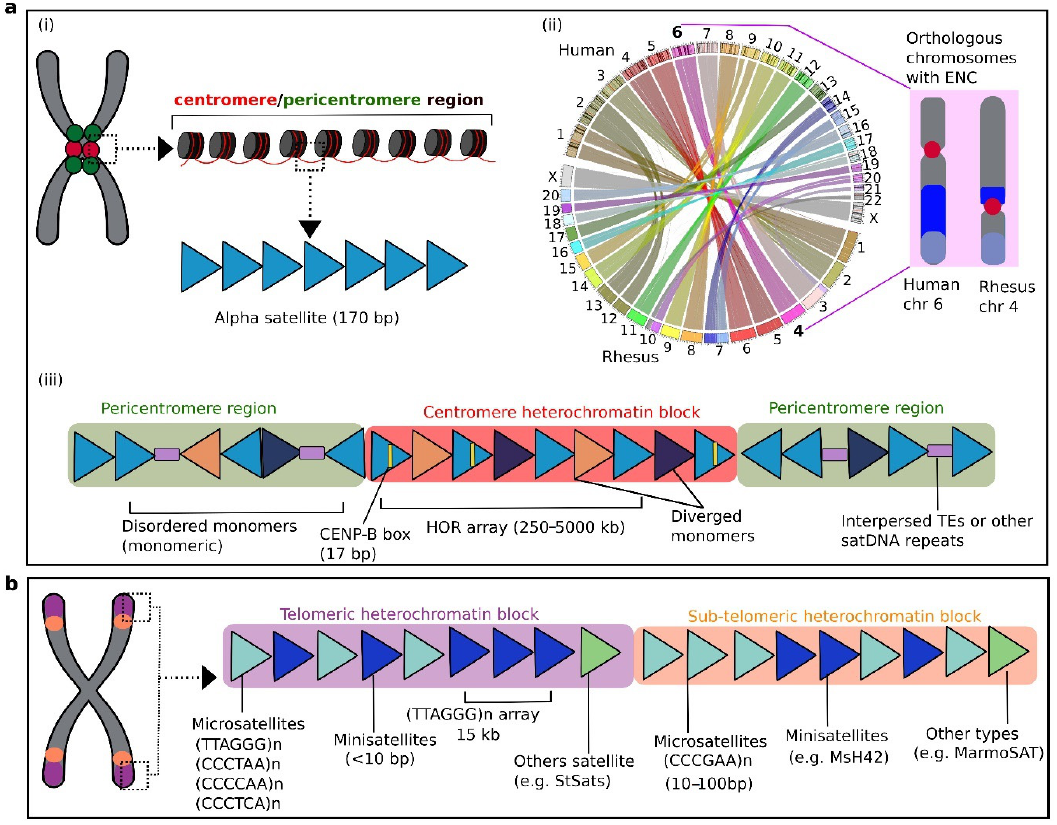
Figure 3. Schematic illustration of satellite DNA repeats and their organization in primate genomes. ( a ) (i) Primate centromeric (red) and pericentromeric (green) regions are enriched with alpha satellite (AS) DNA as the most abundant satellite repeats of primate genomes and form the bulk of the heterochromatin core. (ii) A sketch highlighting the orthologous chromosomes and centromeric repositioning as evolutionary new centromeres (ENCs) between human and rhesus macaque. The circos plot depicts the syntenic relationship between the two genomes. Circos graphics was plotted using Synteny Portal [117]. Note that human chromosome 6 is completely orthologous to macaque chromosome 4, with evolved centromeres [109,116]. (iii) The AS constitute the tandem repeat units (blue triangles) and can be either organized as disordered arrays (monomeric) mostly located in pericentromeres, or highly ordered in a head-to-tail fashion (HORs) forming longer arrays in centromeres. Some monomers may also have a short sequence termed the CENP-B box (yellow line), which binds the centromeric regions to the DNA-binding proteins. Diverged monomers (orange and dark triangles), and interspersed repeats (purple rectangles) are also depicted. ( b ) Telomeric and subtelomeric regions of primate chromosomes are enriched with distinct microsatellites (light blue) and minisatellites (dark blue). Various primate-associated satellite examples are shown.